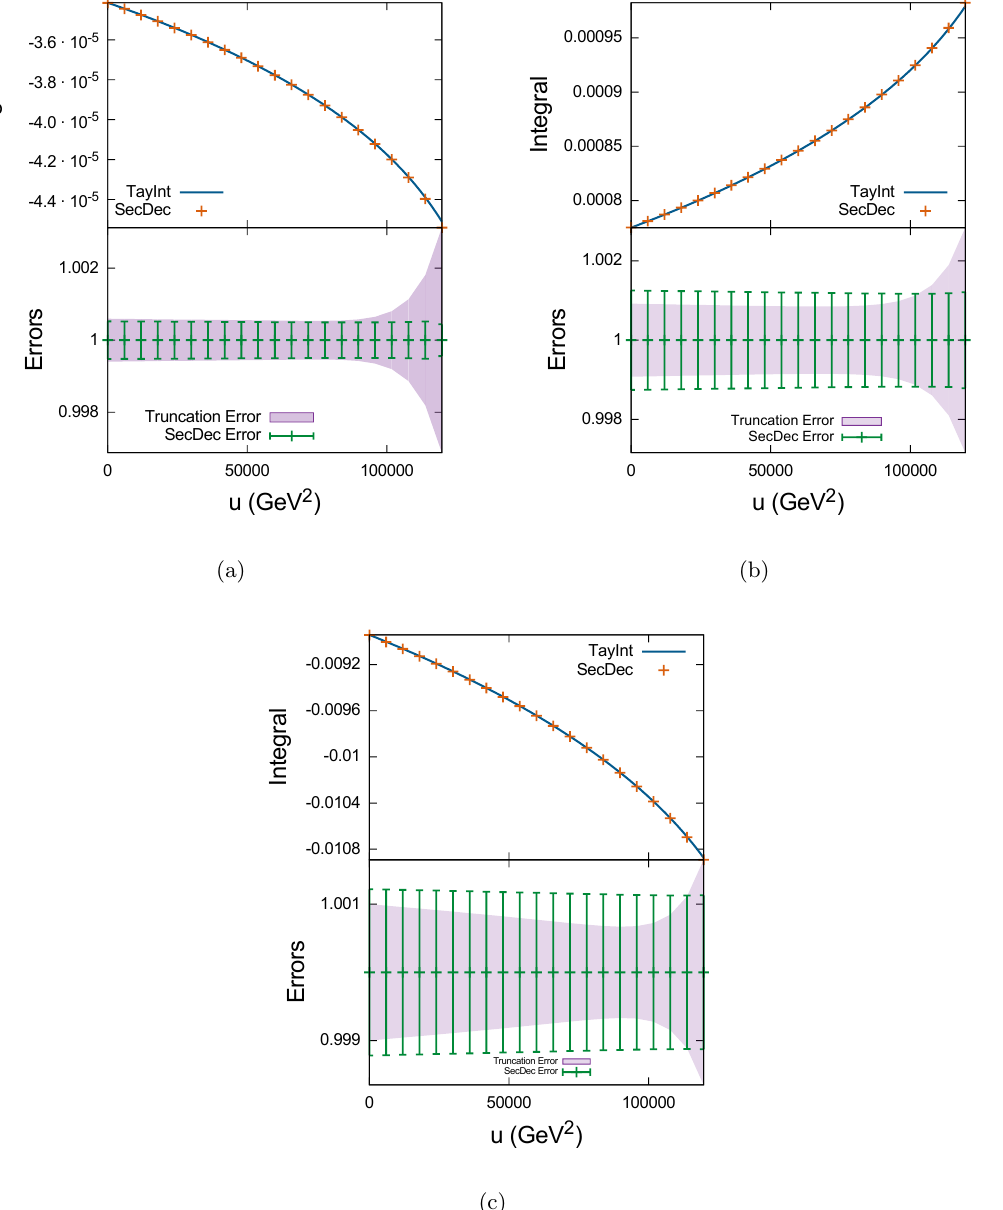
Figure 12 . I10 below threshold, calculated with an eighth-order series expansion at; (a) O ( (cid:15) 0 ), m 1 and m 1 = 173 GeV. The lower plots show the relative (b) O ( (cid:15) 1 ), (c) O ( (cid:15) 2 ) with m 2 = 1 p 2 uncertainties of the TayInt and numerical SecDec results,